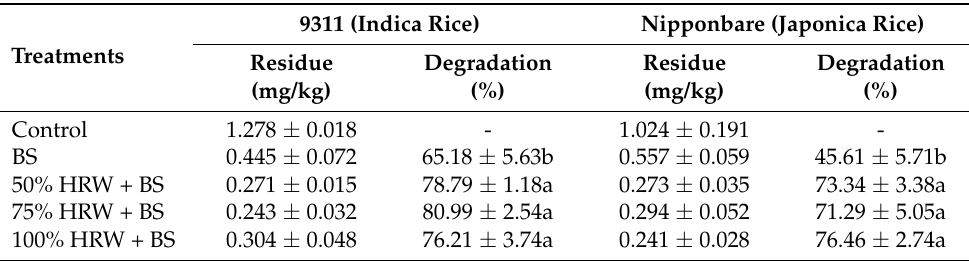
Table 3. Effect of HRW (hydrogen-rich water) pretreatment on the metabolism of the herbicide BS (Bispyribac-sodium) in rice (at five days post